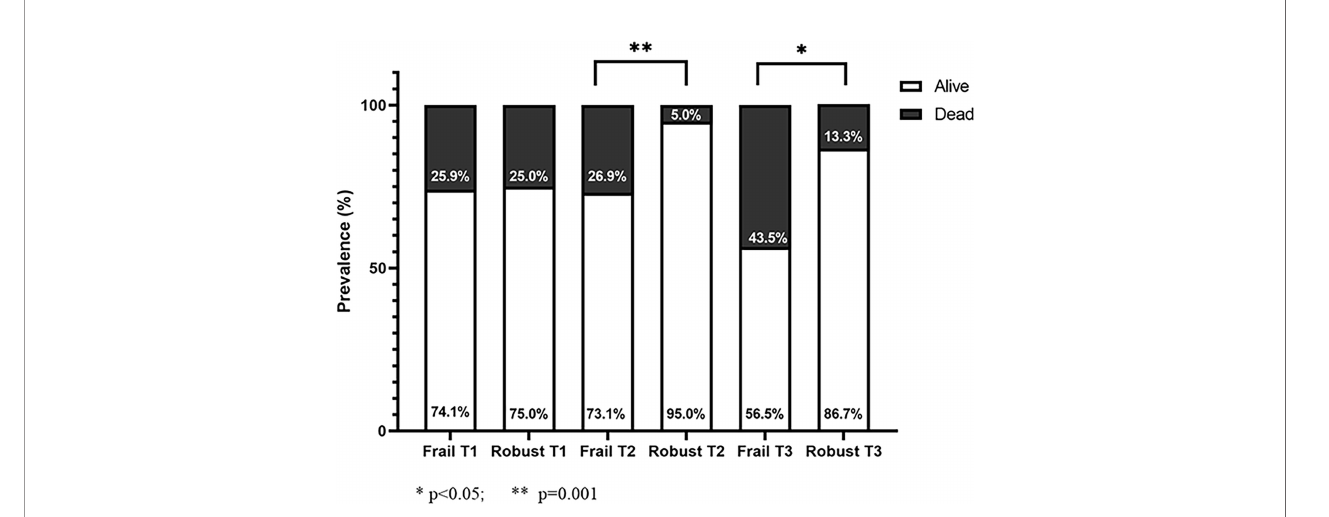
FIGURE 1 | Mortality rate of diabetic patients strati fi ed by frailty degree (frail: CFS ≥ 5; robust: CFS < 5) according to HbA1c